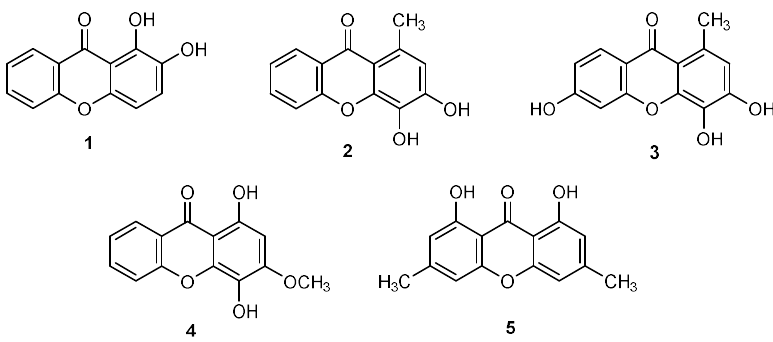
Figure 1. Xanthones investigated in the scope of this work: 1,2-dihydroxy-9 H -xanthen-9-one ( 1 ), 3,4-dihydroxy-1-methyl-9 H -xanthen-9-one ( 2 ), 3,4,6-trihydroxy-1-methyl-9 H -xanthen-9-one ( 3 ), 1,4-dihydroxy-3-methoxy-9 H -xanthen-9-one ( 4 ), and 1,8-dihydroxy-3,6-dimethyl-9 H -xanthen-9-one ( 5 ).